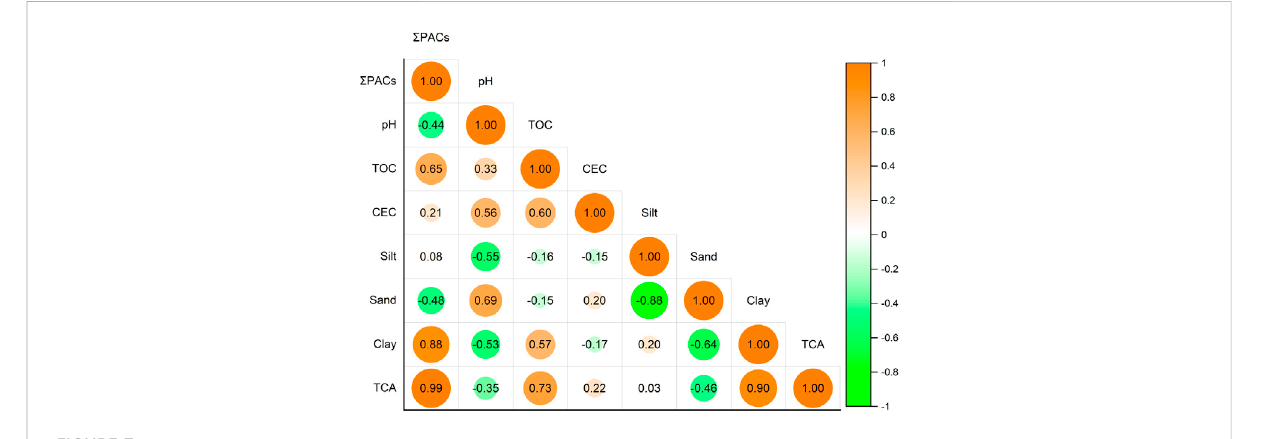
FIGURE 7 Correlation analysis of Σ PAHs concentration and soil